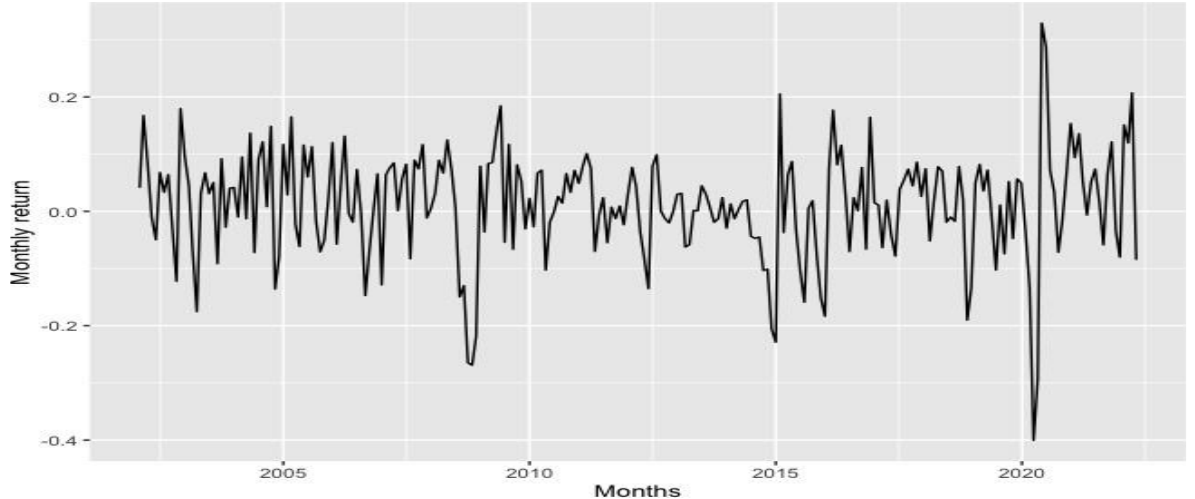
Figure 2: Plot of monthly crude oil returns